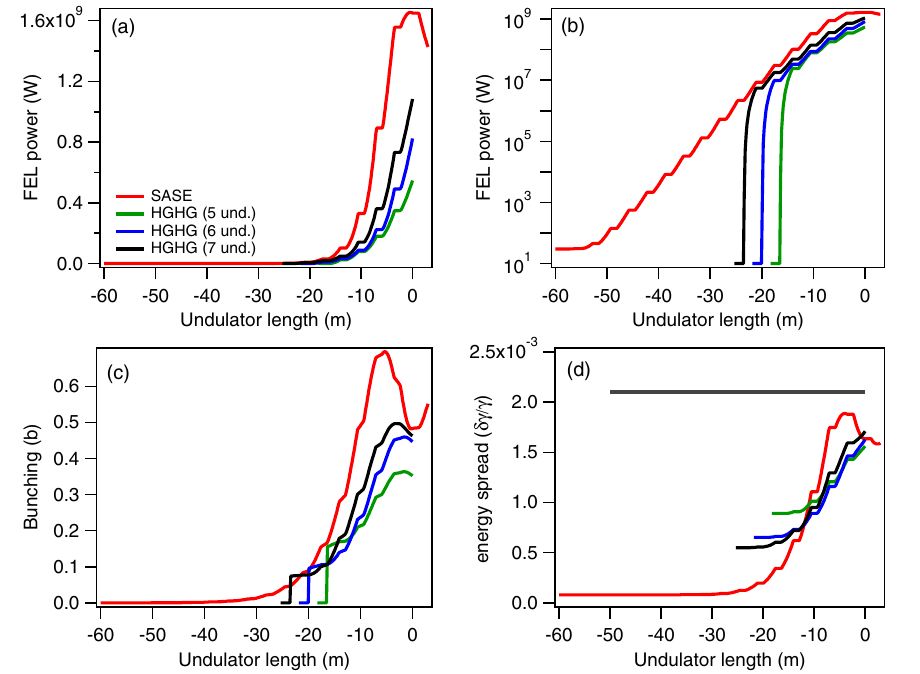
FIG. 2. FEL evolution as a function of radiator length in an amplifier (red) and HGHG with five, six, and seven undulators (green, blue, grey, respectively). FEL power is reported in linear (a) and logarithmic (b) scales, showing a slightly larger gain length for HGHG cases. In all cases the bunching (c) shows a local maximum around the last undulator and relative energy spread (d) that approaches the FEL (cid:2)